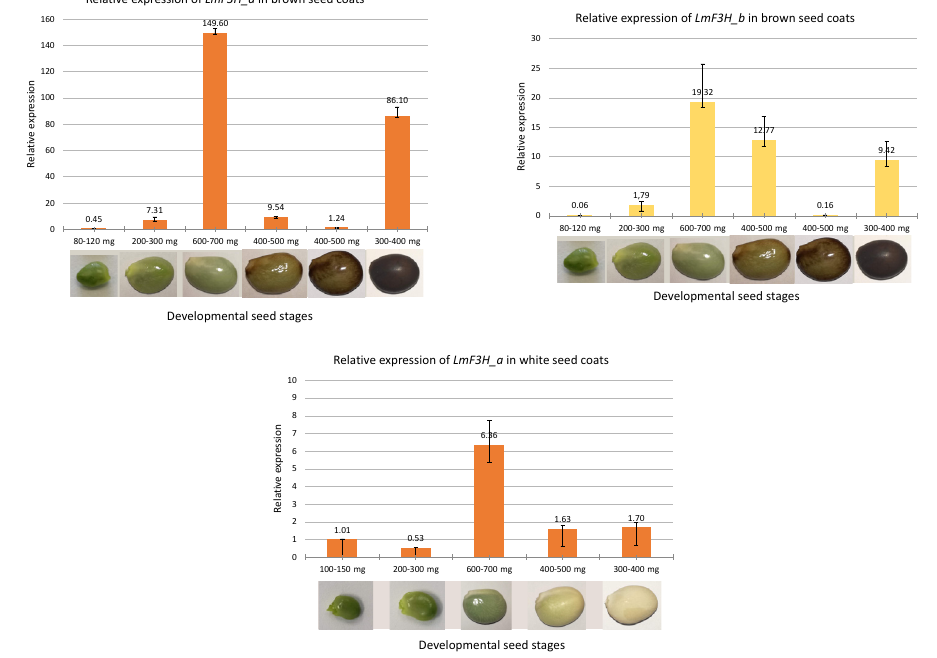
Figure 7. Expression levels (and standard error) of the LmF3h_a and LmF3h_b paralogues in different stage of Lupinus mutabilis seed development, normalised (using initial stage of seed development as control for LM18 and SBP genotype) with Ubc , Hel , Adh3 and α tub reference genes, in different experimental samples. LmF3h_b paralogue is only present in LM18 genotype.